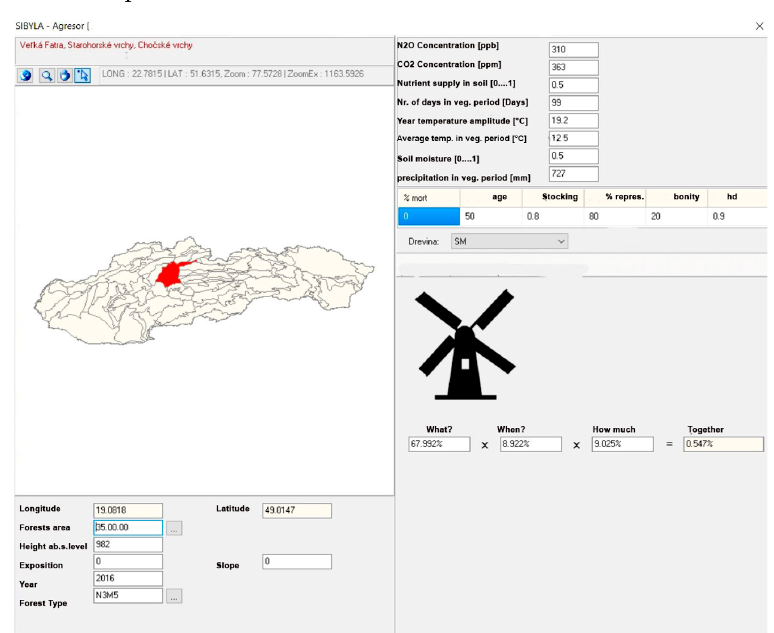
Figure 1. Section of module “Agressor” from software SIBYLA TRIQUETRA.